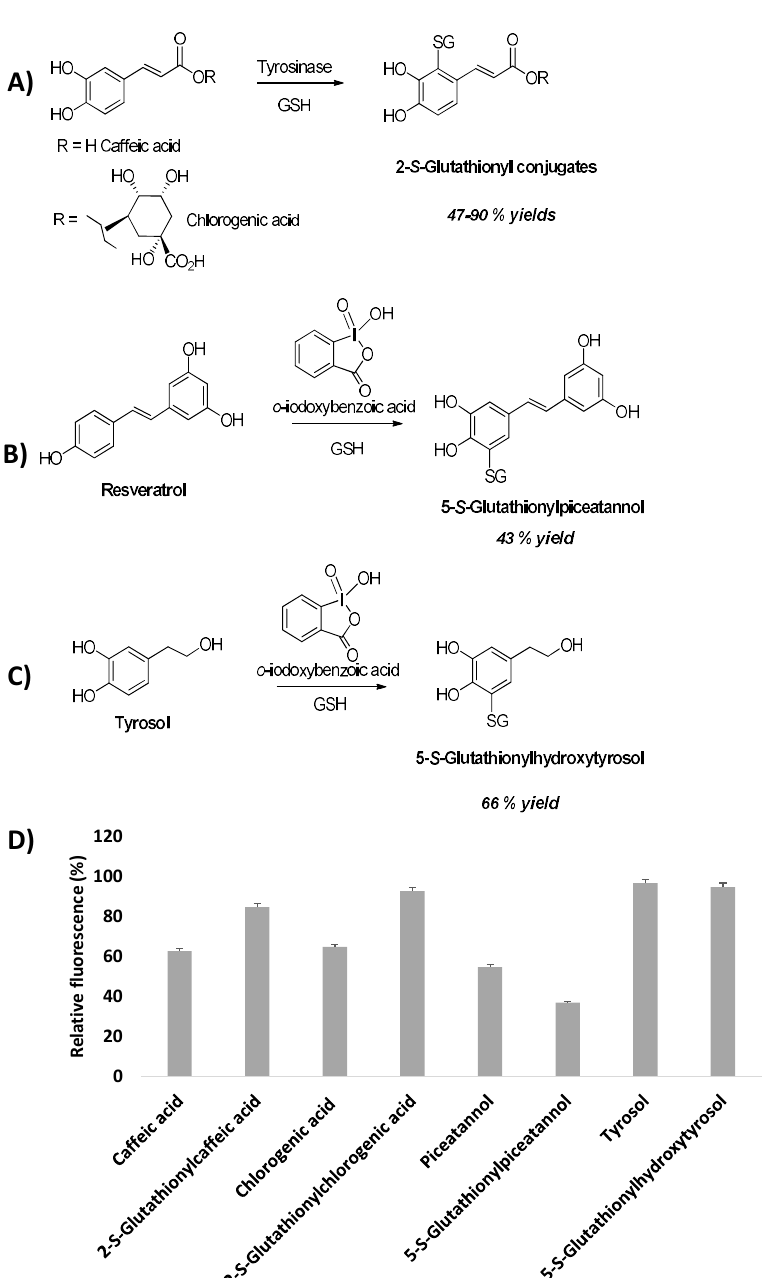
Figure 9. Schematic overview of the glutathionyl adduct formation ( A – C ) and ( D ) effects of catechols and their glutathionyl conjugates on DAN nitrosation at pH 4.0 measured as fluorescence emission at 450 nm of naphtho